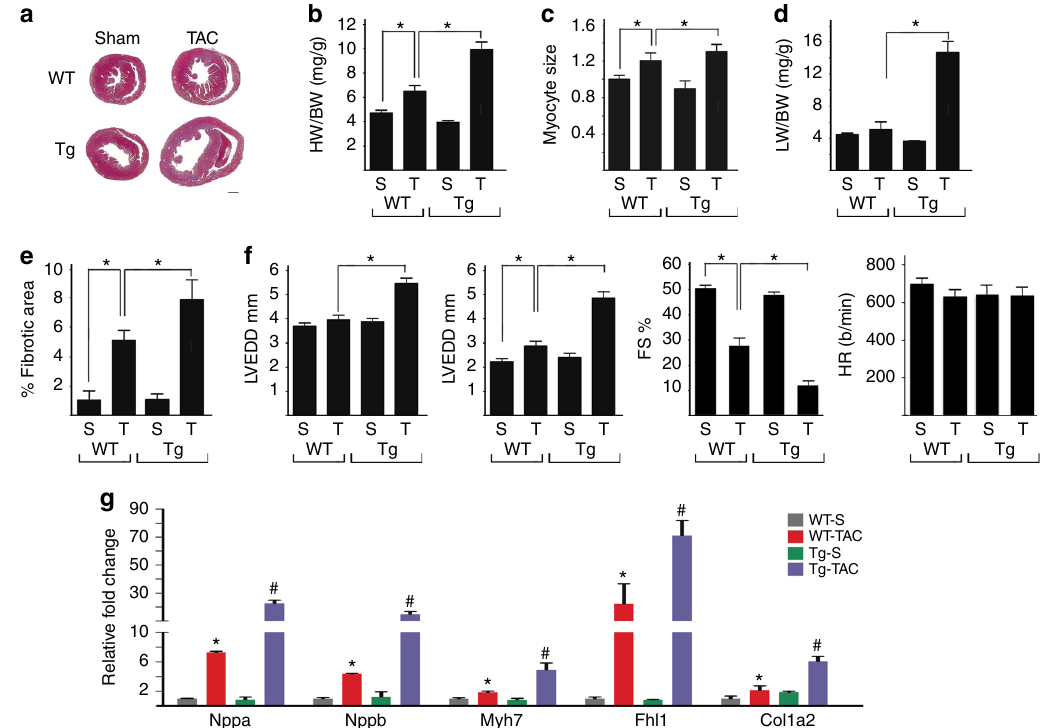
Fig. 2 KDM3A promotes TAC-induced hypertrophic remodeling. WT and Kdm3a -Tg (Tg) mice were subjected to Sham (S) and TAC (T) surgery. Echocardiograph was performed on mice and hearts were harvested after 6 weeks for histological and biochemical analysis. a H&E staining of histologic sections of WT and Kdm3a -Tg mouse hearts. Scale bar, 1 mm. b HW/BW, c relative myocyte cell size, d LW/BW, and e relative fi brotic area of WT and Kdm3a -Tg mouse hearts. f Left ventricular end diastolic diameter (LVEDD), left ventricular end systolic diameter (LVESD), percent of fractional shortening (FS%), and heart rate (HR, beat/min). g Relative mRNA of canonical fetal gene markers (Nppa, Nppb, and Myh7), Fhl1, and Col1a2. n = 6-10 ± SEM. *, # p < 0.05 (ANOVA). *WT TAC vs. WT Sham. # , Tg-TAC vs. Fig. 6b). To test if JIB-04 targets KDM3A in TAC-induced pathological hypertrophic remodeling in vivo, we treated sham and TAC WT and Kdm3a -Tg mice with JIB-04 or vehicle (administered by gavage) (Fig. 6a) at a dose with no overt toxi- city 22 . Administration of JIB-04 preserved cardiac function (Fig. 6b) and suppressed hallmarks of pathological hypertrophic remodeling in both WT and Kdm3a -Tg hearts, including atte- nuated HW/BW (Fig. 6c) and reductions in cardiomyocyte size (Fig. 6d), fi brosis (Fig. 6e), and canonical fetal gene expression (Fig. 6f). JIB-04 also attenuated upregulation of TAC-induced Timp1 expression at RNA (Fig. 6f) and protein levels (Fig. 6g). We